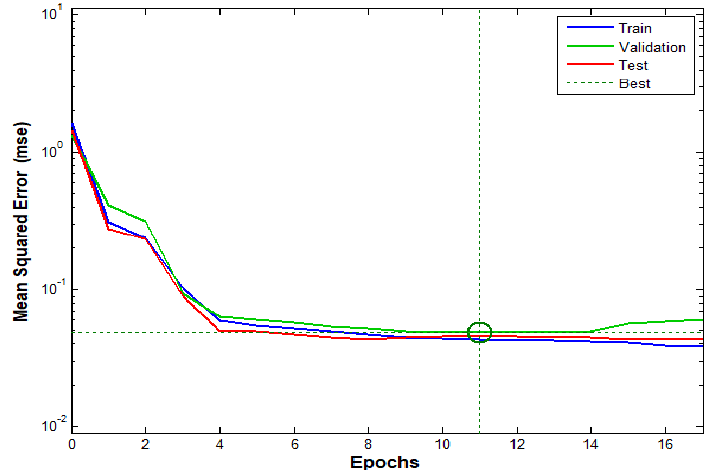
Figure 8. Validation performance of the model.